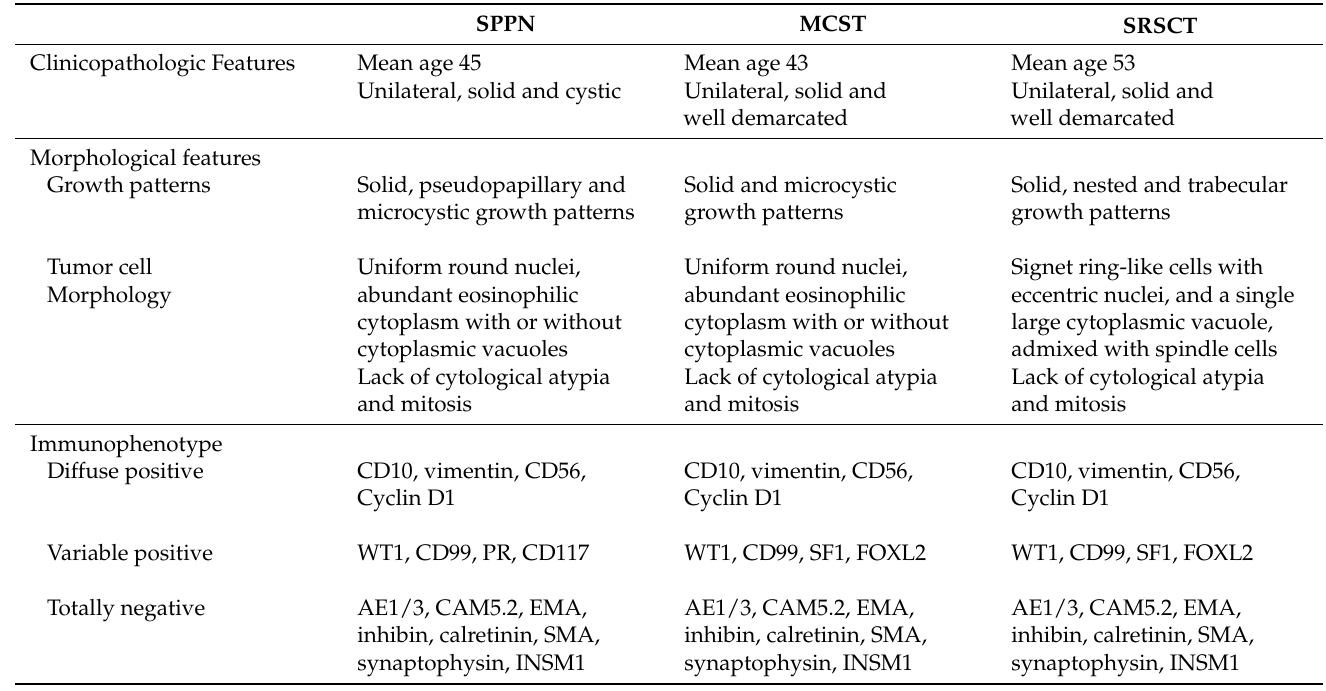
Table 1. Clinical, Pathological and Immunohistochemical Features and Genetic Alteration of β -catenin in Ovarian SPPN, MCST and